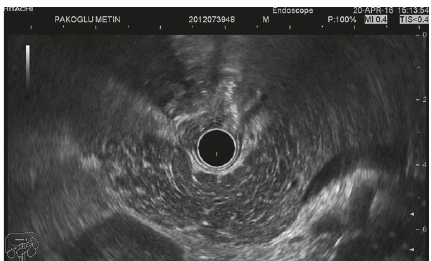
Figure 3: A radial endosonographic image for indeterminate for chronic